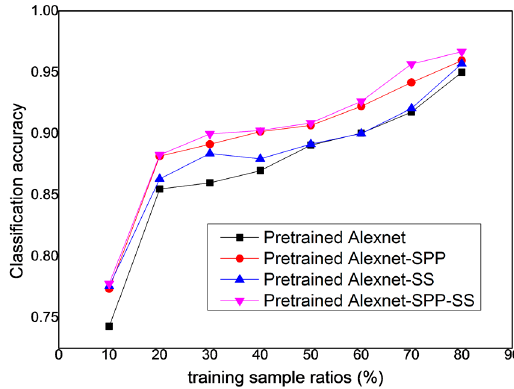
Figure 17. The influence of the training sample ratios with the different algorithms for the UC Merced dataset.